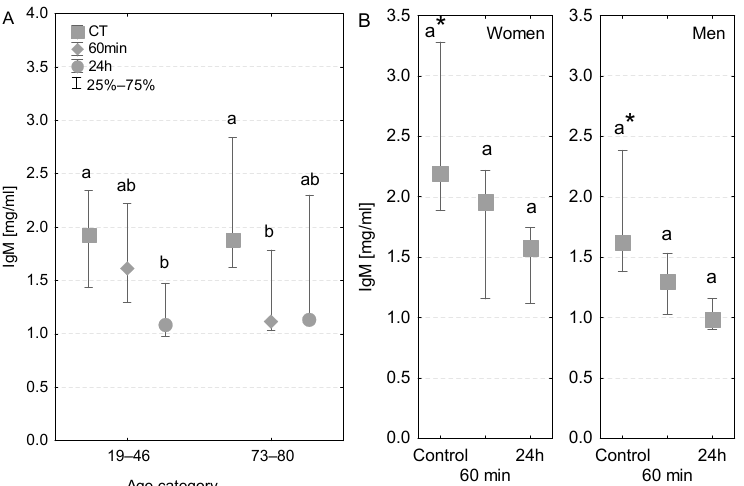
Figure 3. Serum IgM concentration (median ± quartile deviation; 25th and 75th percentiles). ( A ) Comparison based on the age of patients: 19–46 years and 73–80 years. ( B ) Comparison based on the sex of the patients. CT: measurement before the onset of CPB; 60 min: measurement at 60 min of the CPB onset; 24 h: measurement at 24 h after the onset of CPB. Values with different letters (a, b) indicate significant differences within the age or sex category (Friedman’s test or Mann–Whitney U test; p < 0.05); * indicates statistical difference between women and men; p < 0.05.